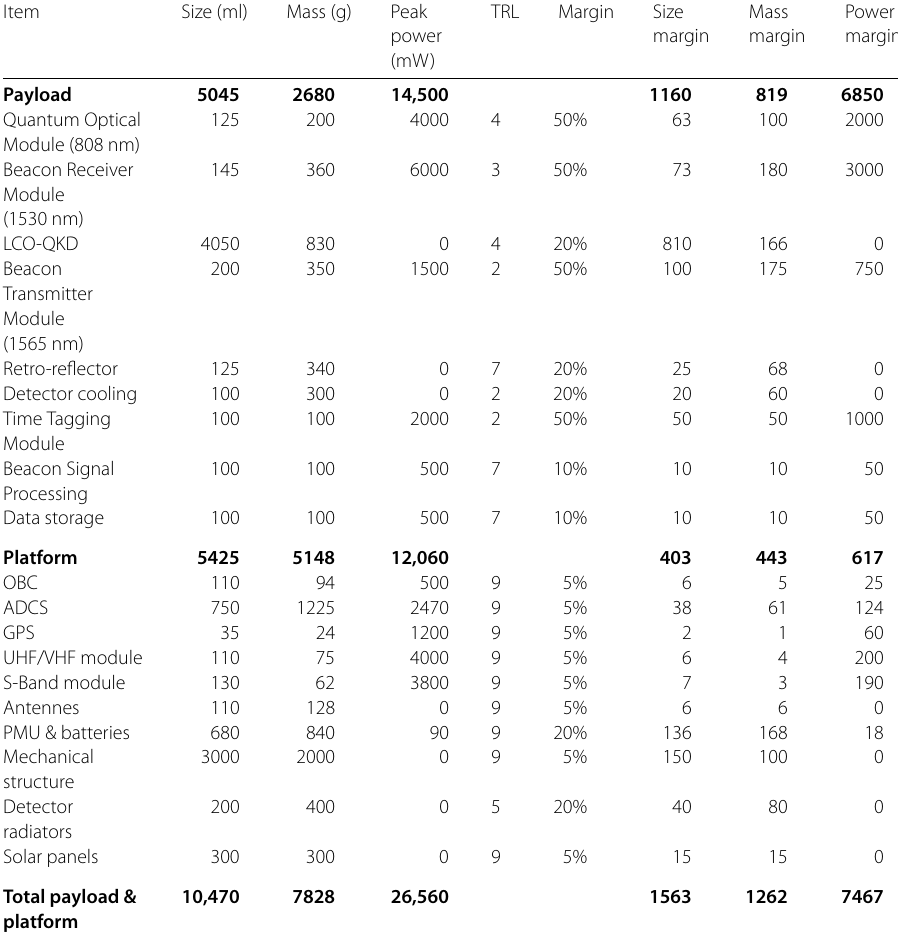
Table 1 Results of a SWaP (Size, Weight (Mass), and Power) analysis, including